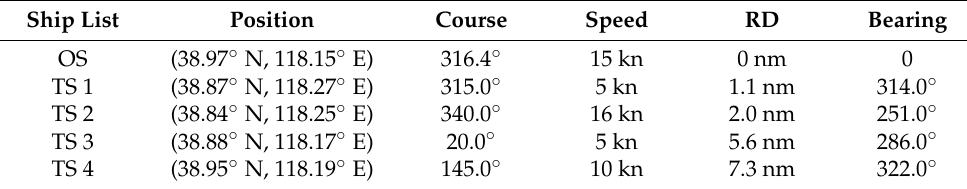
Table 6. Initial information (multi-ship encounter into open water).